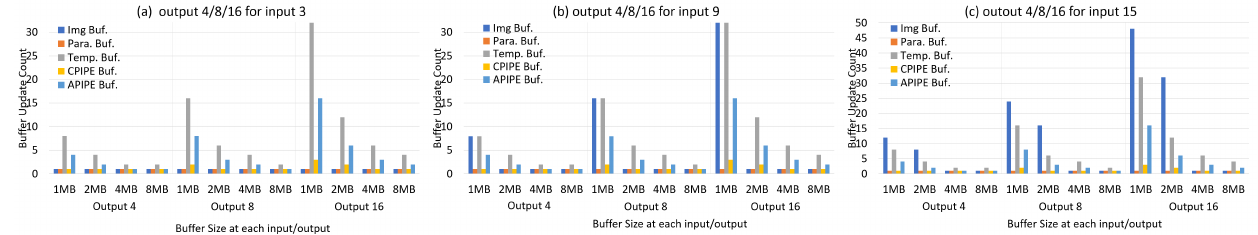
Figure 8. It plots access frequency of each buffer in developed DLA according to the change in buffer size from 1 MB to 8 MB for each CNN configuration.